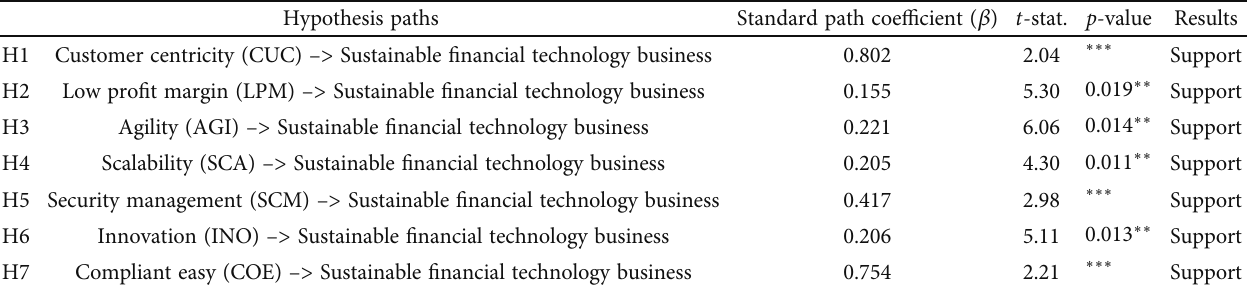
Table 6: Testing hypothesis results.